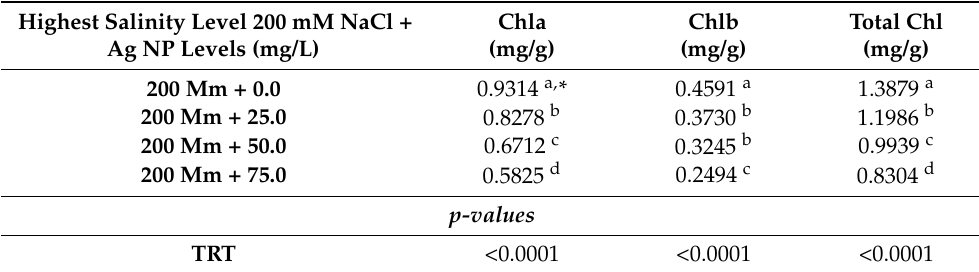
Table 4. Chlorophyll content of the Q6 quinoa plantlets grown under the highest NaCl level after adding different levels of Ag NPs.